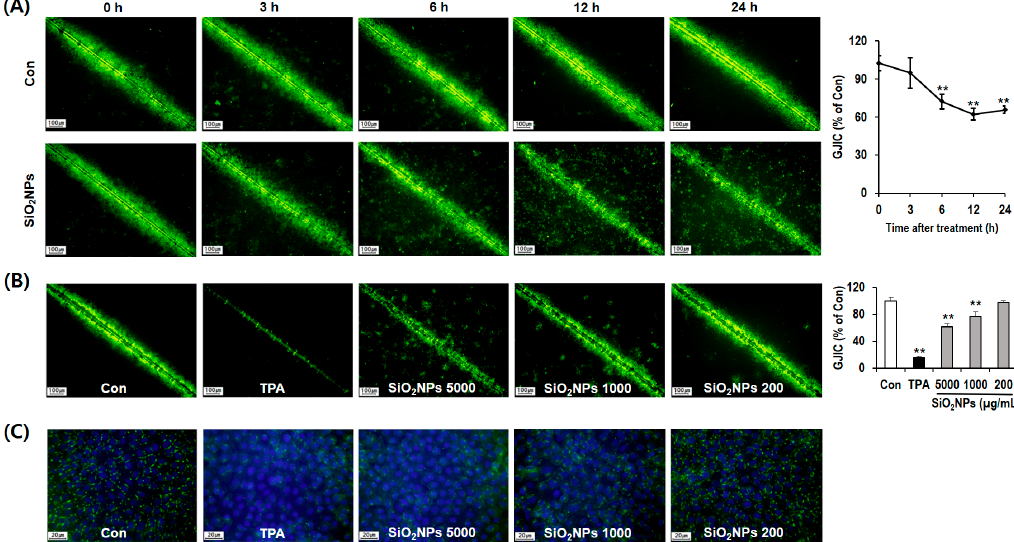
Figure 5. E ff ects of SiO 2 NPs on gap junctional intercellular communication (GJIC) and Cx43 protein in WB-F344 cells. ( A ) Representative scrape loading / dye transfer (SL / DT) assay for time-course study on GJIC and quantitative analysis after the treatment with 5000 µ g / mL SiO 2 NPs. ( B ) Representative SL / DT assay for dose–response study on GJIC and quantitative analysis after the treatment with SiO 2 NPs for 12 h at doses of 200, 1000, and 5000 µ g / mL. Then, 10 ng / mL 12-O-tetradecanocylphorbol-13-acetate (TPA) was treated as a positive control. ( C ) E ff ects of SiO 2 NPs on the distribution of Cx43. Distribution of Cx43 levels (green) was detected by immunofluorescence staining after the treatment with SiO 2 NPs for 12 h at doses of 200, 1000, and 5000 µ g / mL. Then, 10 ng / mL TPA was treated as a positive control. Nuclei were stained with 4 (cid:48) ,6-Diamidino-2-phenylindole dihydrochloride (DAPI )(blue). Bar represents 1.0 mm. Data expressed as means ± SD (* p < 0.05 and ** p < 0.01).